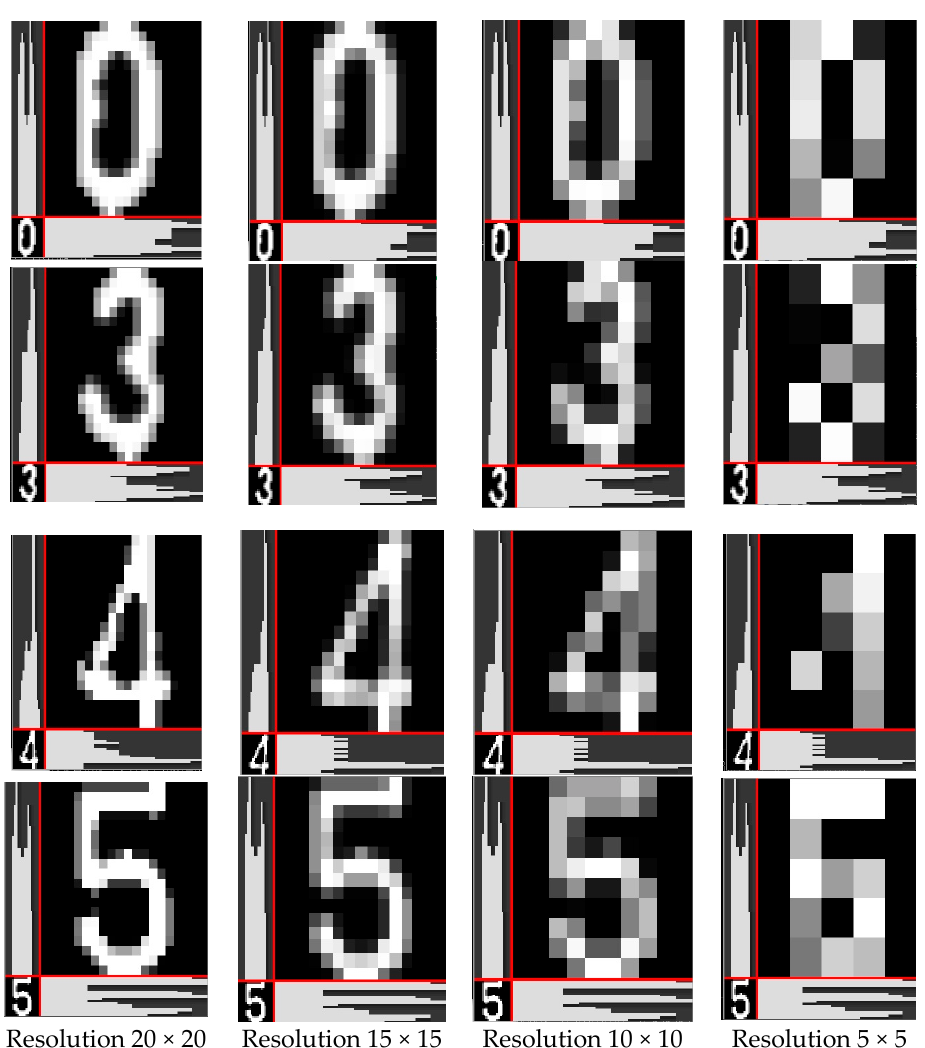
Figure 11. Examples of three feature quantities for each number 0, 3, 4, and 5.